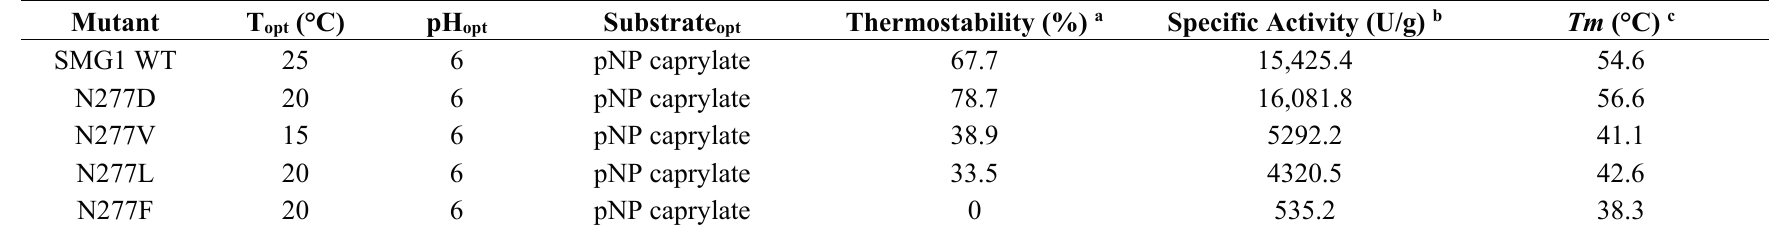
Table 1. Thermostability and basic properties of SMG1 WT and its